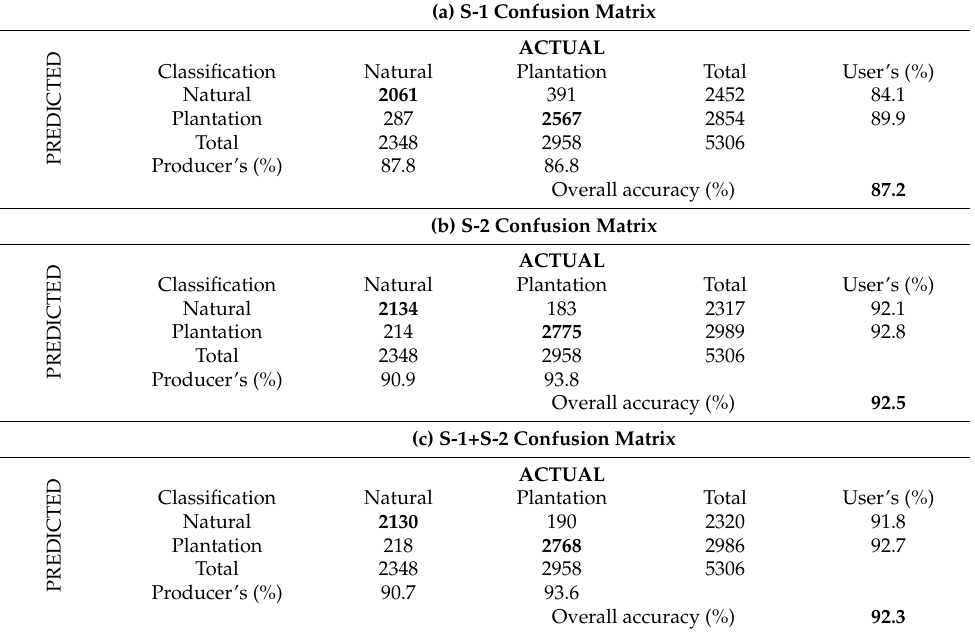
Table 1. Confusion matrices for (a) Sentinel-1 only (b) Sentinel 2 only and (c) Sentinel 1 and 2 combined Random Forest classifications of natural and plantation forest. The bold text denotes correct classifications and the overall